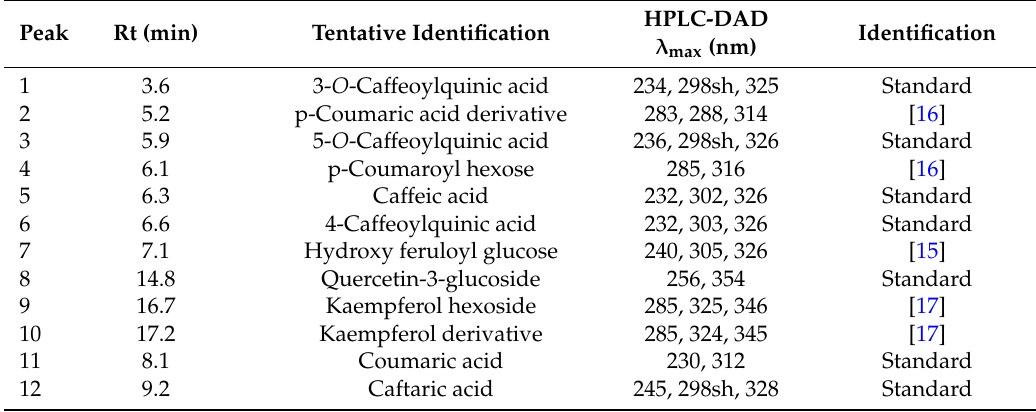
Table 1. Identification of polyphenolic compounds in apricot leaf samples.